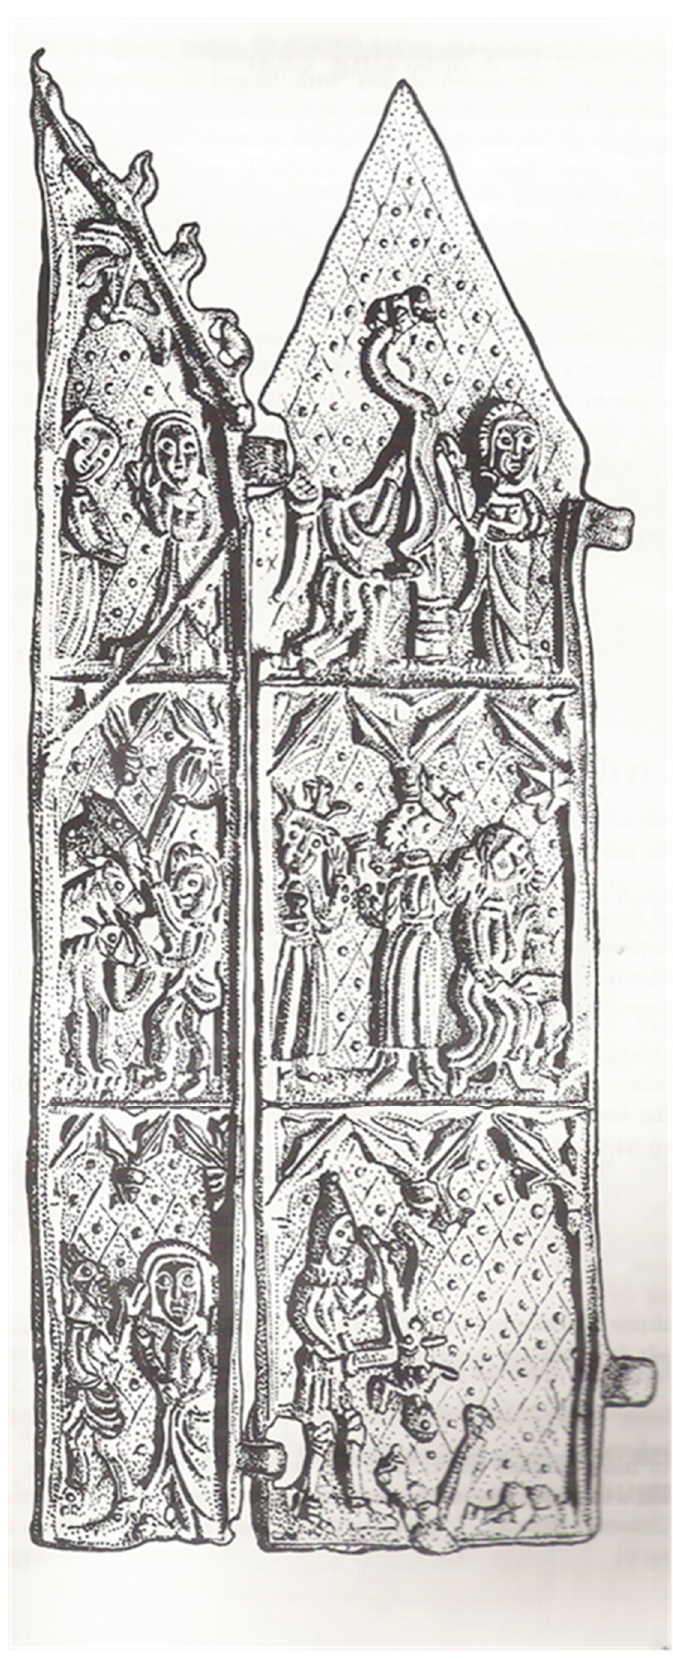
Figure 9. Pilgrim souvenir triptych, first half of the 14th century. Norfolk, Lynn Museum. Photo: After Spencer, Medieval Pilgrim Badges from Norfolk , pp. 26–27.